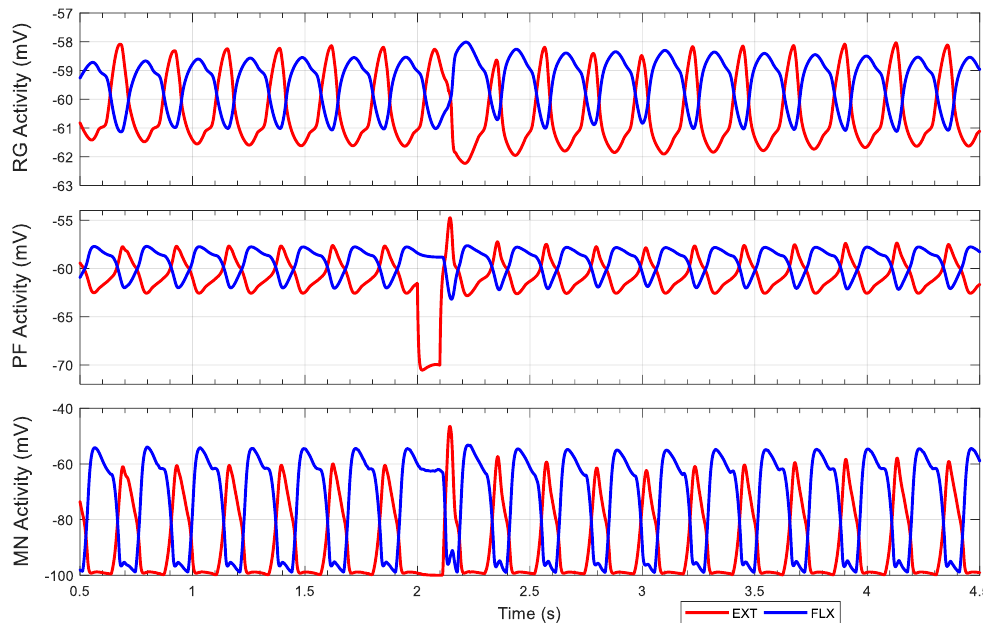
Figure 9. Neuron activities during non-resetting experiment. Inhibitory stimuli applied to the left hip pattern formation extensor neuron from 2 s to 2.1 s with a current of − 10 nA. MN: Motoneuron; PF: Pattern formation; RG: Rhythm generation.